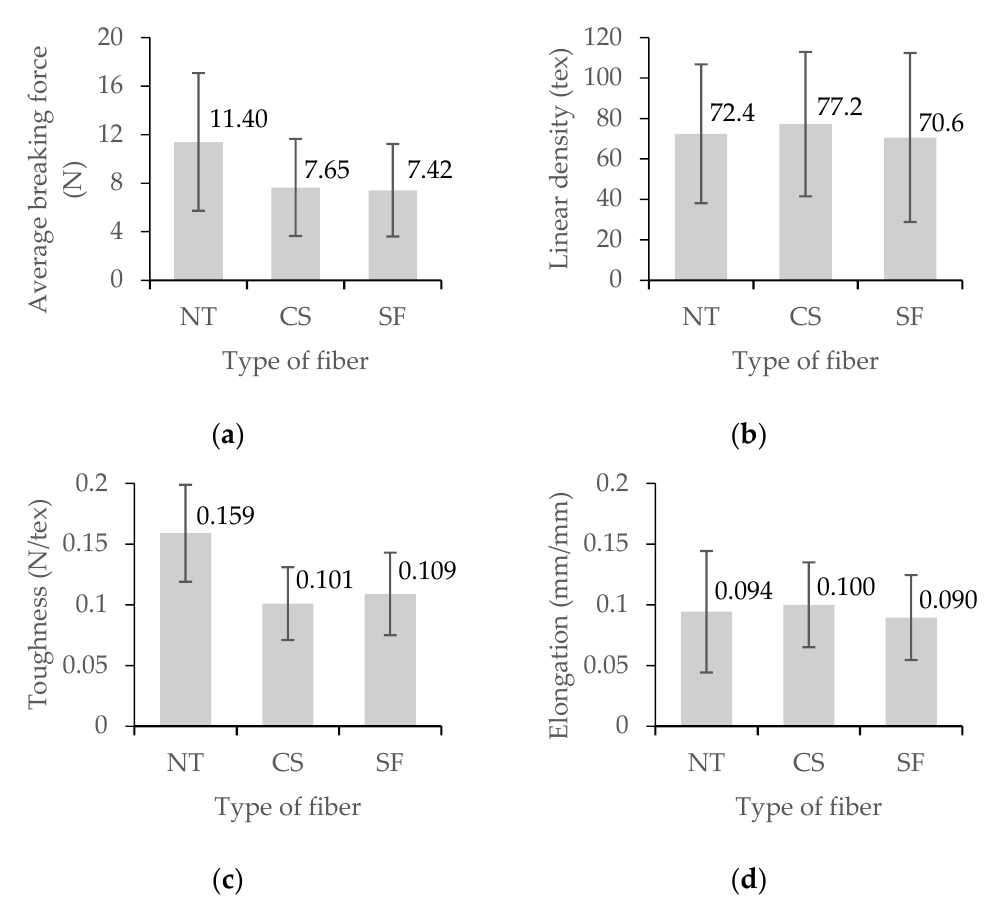
Figure 3. ( a ) Average breaking strength, ( b ) linear density, ( c) toughness, and ( d ) elongation.